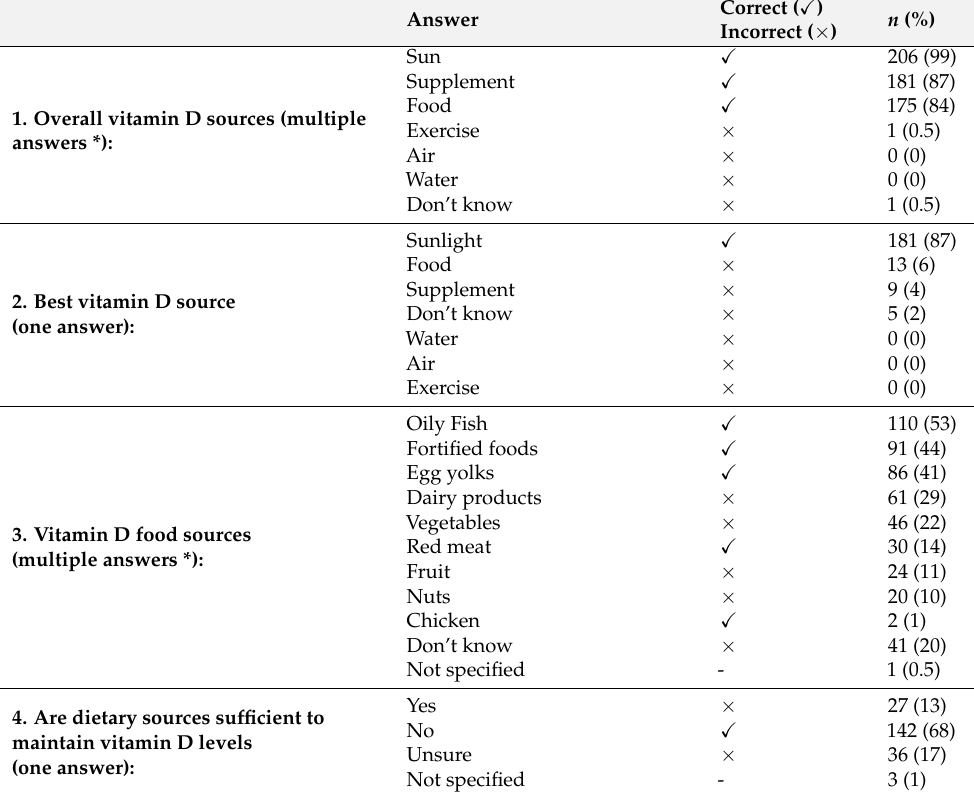
Figure 1. Overall knowledge scores of participants ( n = 208, one participant did not respond). Table 2. Participants’ knowledge of vitamin D ( n = 208, one participant did not respond); 10 questions used in vitamin D knowledge score calculation.